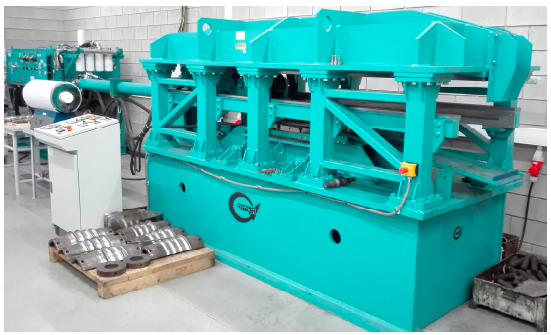
Figure 1. Laboratory stand for cross rolling—flat wedge rolling mill. Table 3. Technical specification of the cross rolling mill located in the Lublin University of Technology.